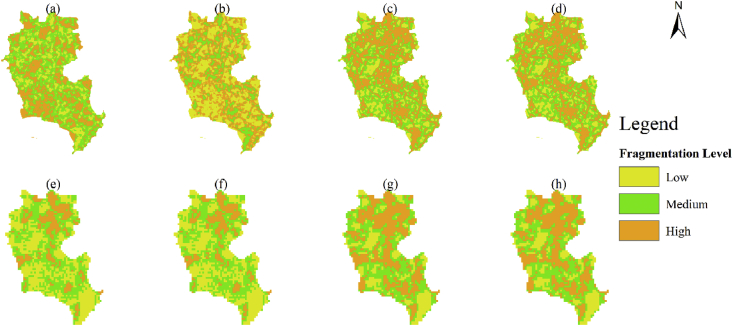
Fragmentation level based on the landscape metrics. a, b, c, and d are at R30m. e, f, g, and h are at R500m. (a) and (e) are NP, (b) and (f) are PD, (c) and (g) are DIVISION, (d) and (h) are MESH.